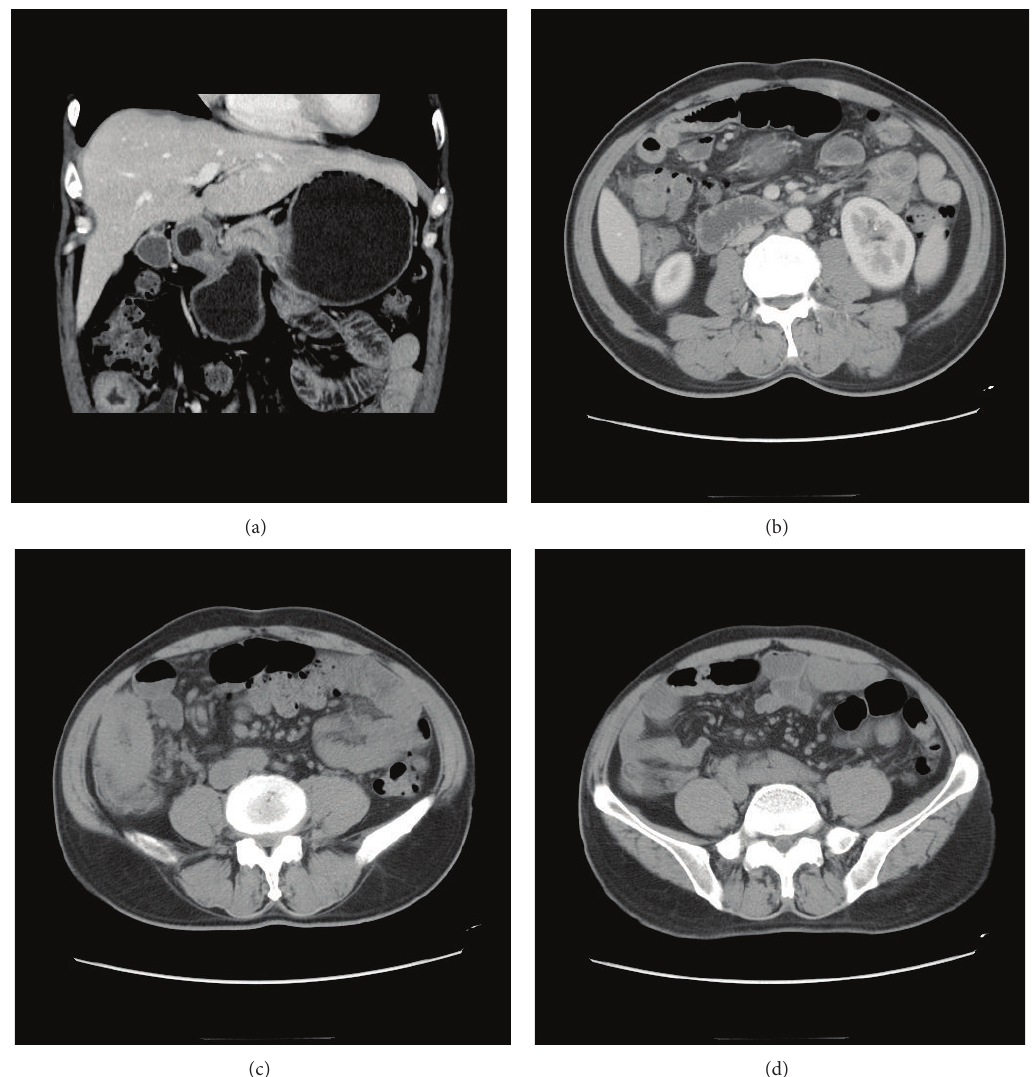
Figure 3: HRCT scan of the abdomen showed severe segmental narrowing, a cobblestone appearance of the terminal ileum, small-bowel wall thickening, and mesenteric